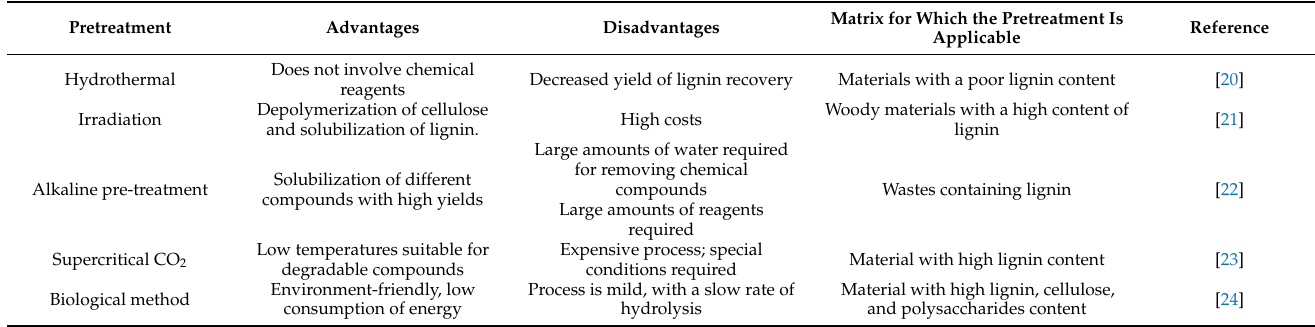
Table 1. Short presentation of advantages and disadvantages of the pretreatment